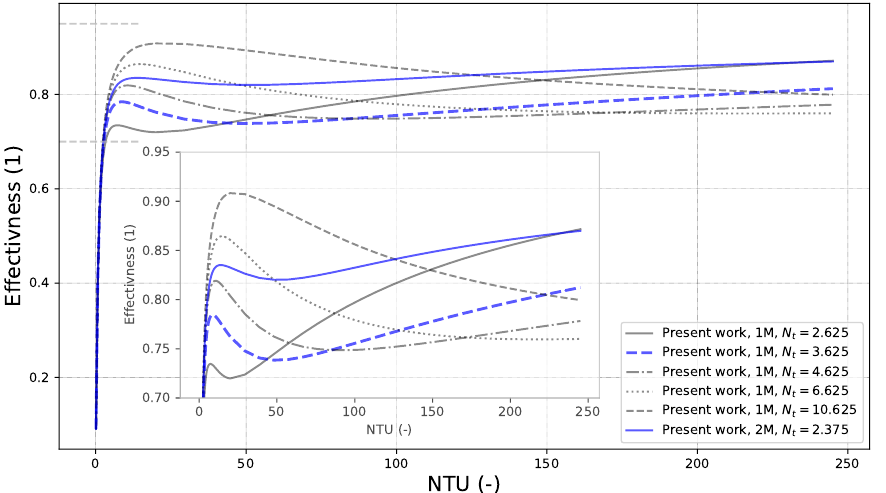
Figure 5. Effect of N t on predicted effectiveness parameter for one- and two-module SPHEs. 2M, N t = 2.375 is equivalent to 1M, N t = 3.625.